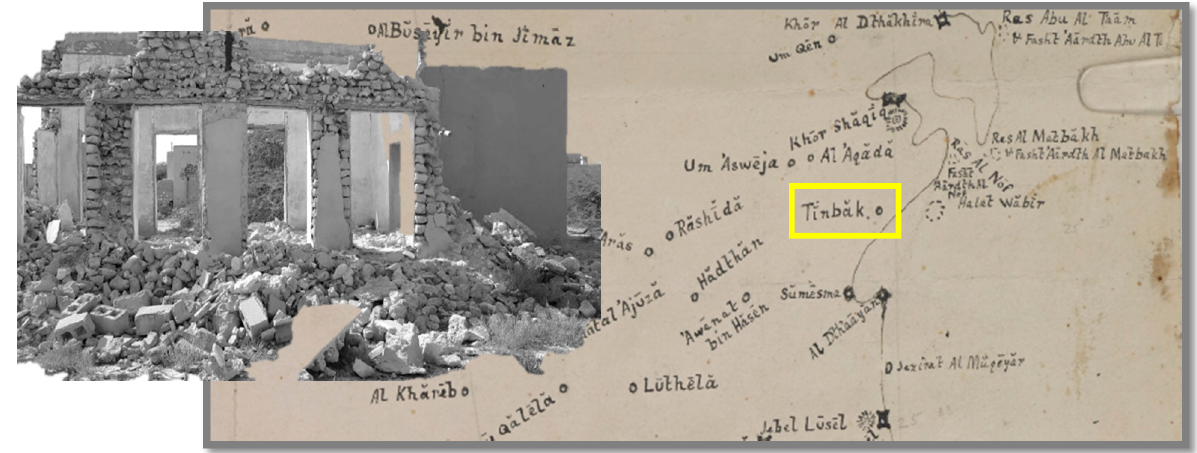
Figure 1. A map of Qatar in 1934 by a British political agent (Qatar National Digital Library, 2020). The image to the left is a building ruin in Tinbak (Authors).